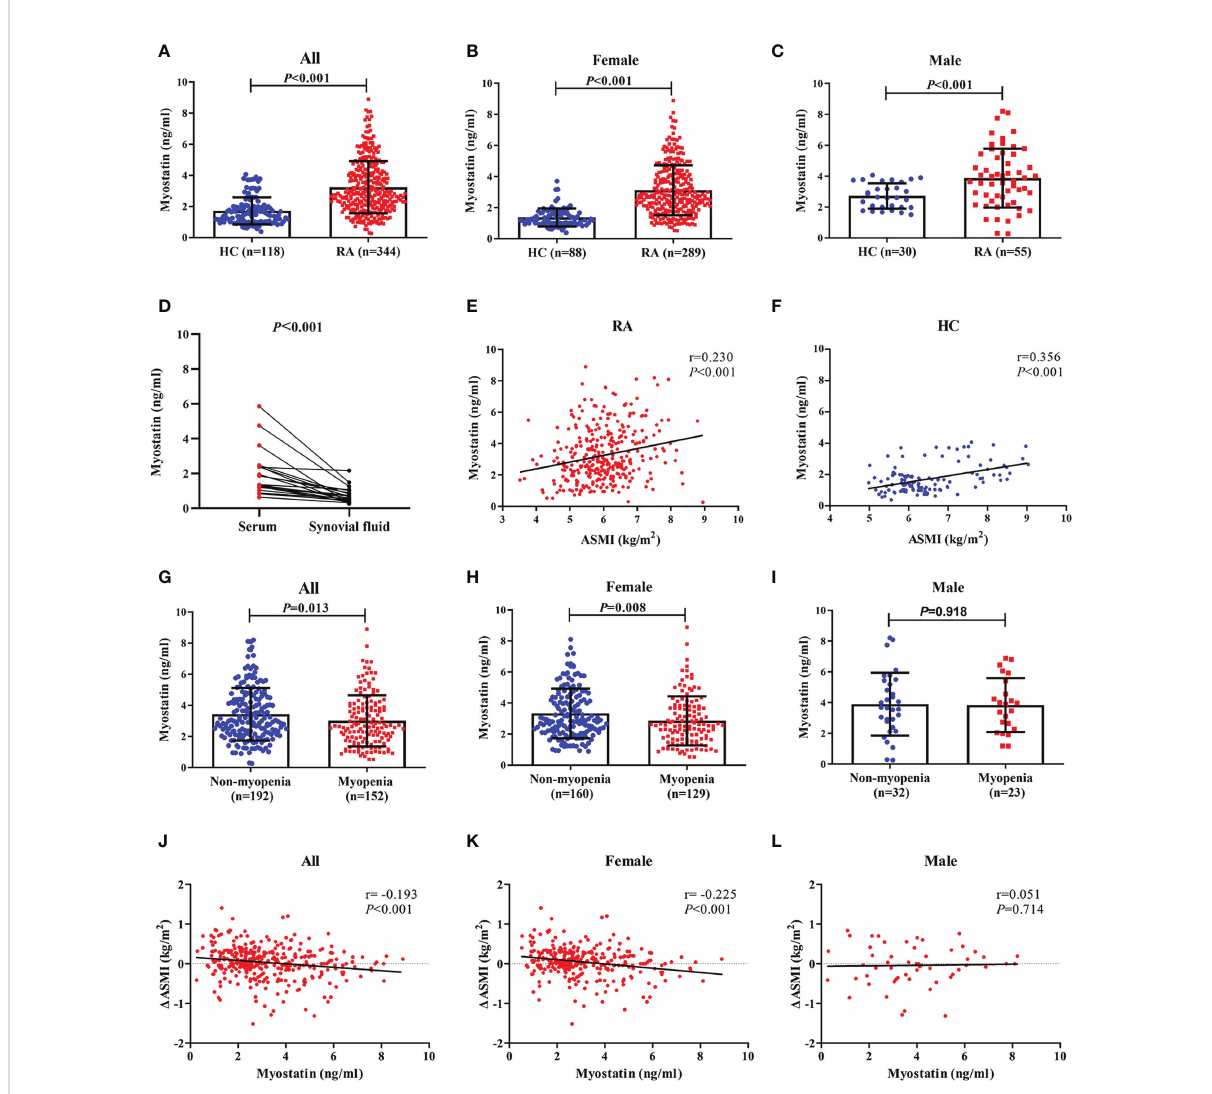
FIGURE 1 Baseline myostatin level in RA patients and healthy controls. Baseline serum myostatin level in RA patients and healthy controls (A – C) , Baseline myostatin of matched serum and synovial fl uid from the same RA patients (D) , Relationship between serum myostatin and ASMI in all RA patients and healthy controls (E, F) , Baseline serum myostatin level in RA patients with myopenia and non-myopenia (G – I) Relationship between serum myostatin and D ASMI in RA patients (J – L) . RA, rheumatoid arthritis; HC, healthy controls; ASMI, appendicular skeletal muscle mass index; D ASMI, a change in ASMI from baseline to 12